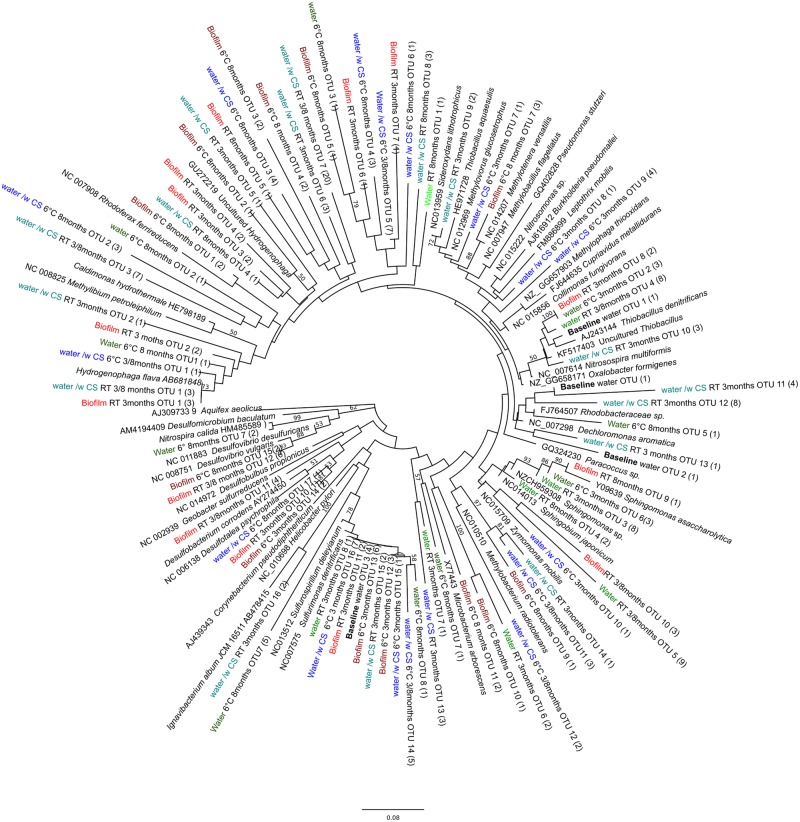
Phylogenetic tree of bacterial diversity, based on the 16S rRNA gene sequences obtained by 16S gene-based PCR-DGGE, in relation to cultured- and the closest uncultured relatives. Parentheses indicate the number of individual sequences within the OTU. Bootstrap values, calculated from 1,000 repetitions, are shown at branch points with >50% support. The scale bar indicates 0.08 nucleic acid substitutions. The tree is rooted by Aquifex aeolicus.